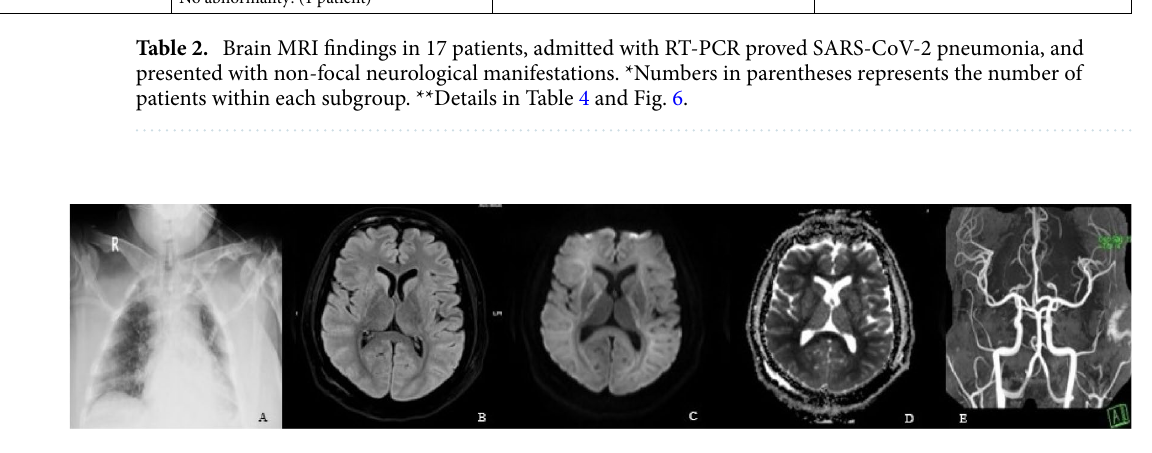
Figure 5. Twenty-six-year-old male with no prior co-morbidities; admitted with severe RT-PCR proved SARS- CoV-2 pneumonia, ( A ) as shown on the chest radiogram. This patient, who was on mechanical ventilation, went into cardiac arrest. Brain MRI was performed 4 days post arrest due to low GCS (= 6), revealed global hypoxic- ischemic encephalopathy. ( B ) Axial FLAIR image, at the level of the BG, showed decreased signal intensity in the thalami, while ( C ) corresponding DWI image showed lack of hyperintensity in both thalami, in addition to the caudate and putamen nuclei, findings that represent pseudo normalization. ( D ) Also, corresponding ADC map showed hyperintensity in the locations cited in ( B ). ( E ) Reconstructed maximum intensity projection magnetic resonance angiography (MRA) image shows no large vessel occlusion.